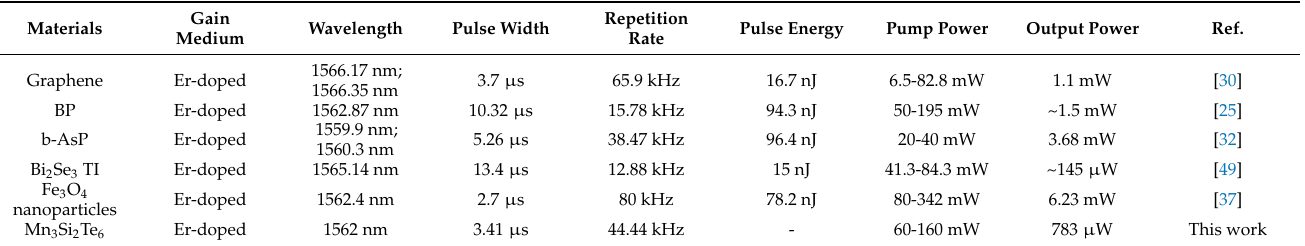
Table 1. Technical parameter comparison of several reported passive Q-switched EDFLs based on nanomaterial